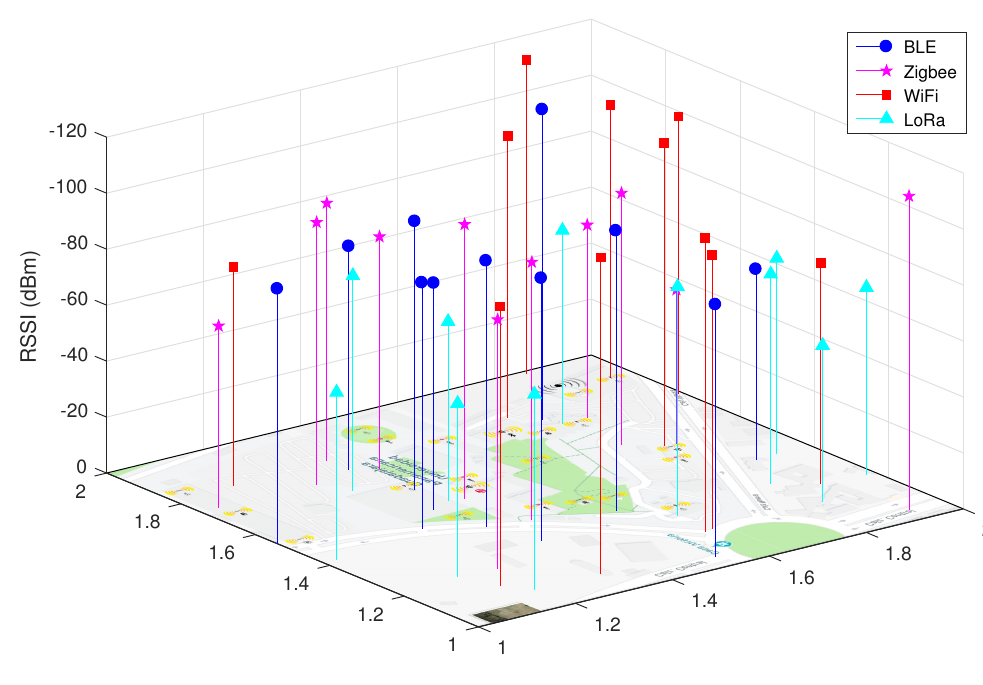
Figure 8. Received Signal Strength Indication (RSSI) values in dBm under cooperation scheme for each technology.